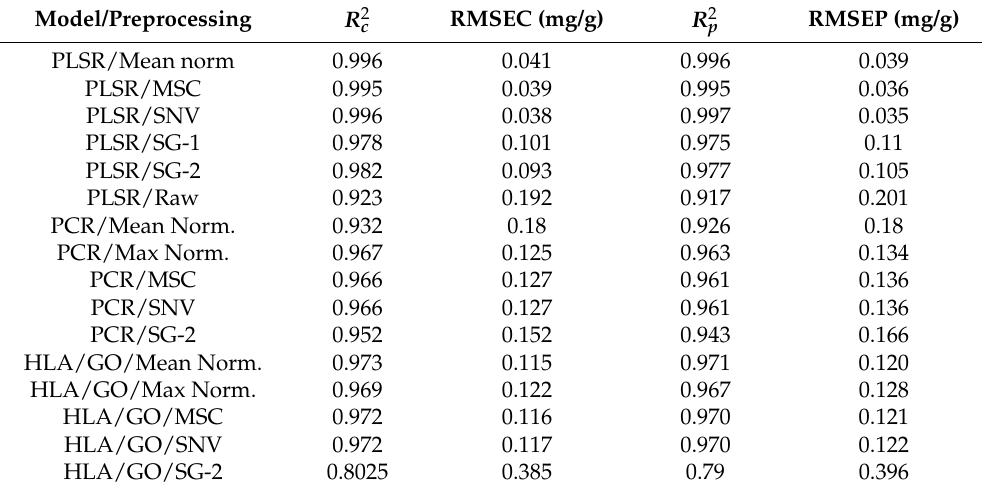
Table 5. Predicted phenolics in moringa powder samples using the PLSR, PCR, and HLA/GO